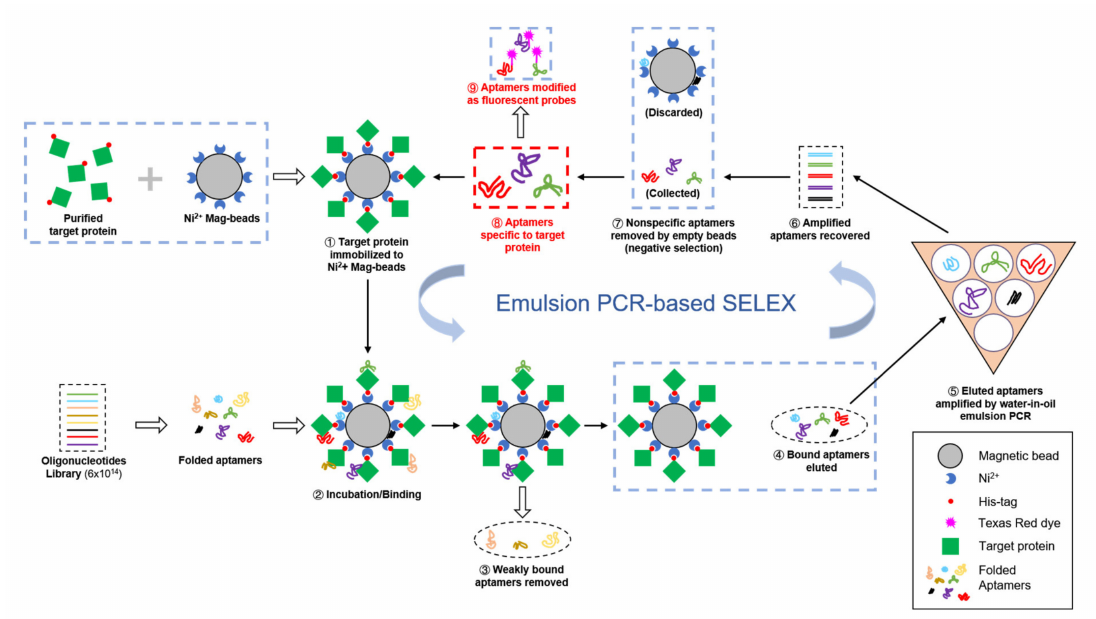
Figure 1. Selection of aptamers against target viral protein by Systematic Evolution of Ligands by Exponential Enrichment (SELEX) with emulsion